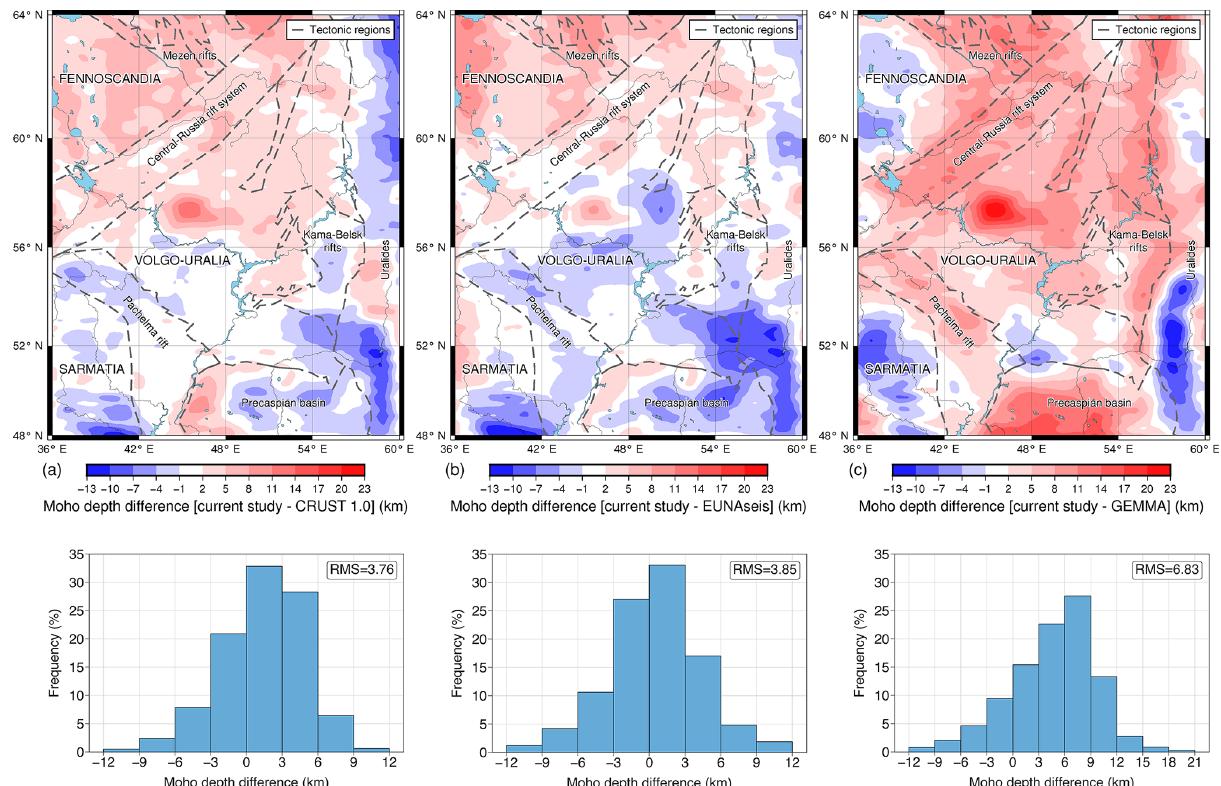
Figure 14. Difference in Moho depths between (a) obtained model developed in IGMAS + and CRUST 1.0 model by Laske et al. (2013), (b) EUNAseis model by Artemieva and Thybo (2013), and (c) GEMMA model by Reguzzoni and Sampietro (2015). The top panel shows the maps of Moho depth residuals calculated as depth to Moho of the current study minus depth to Moho from the selected models in km. The bottom panel shows histograms of Moho depths differences in